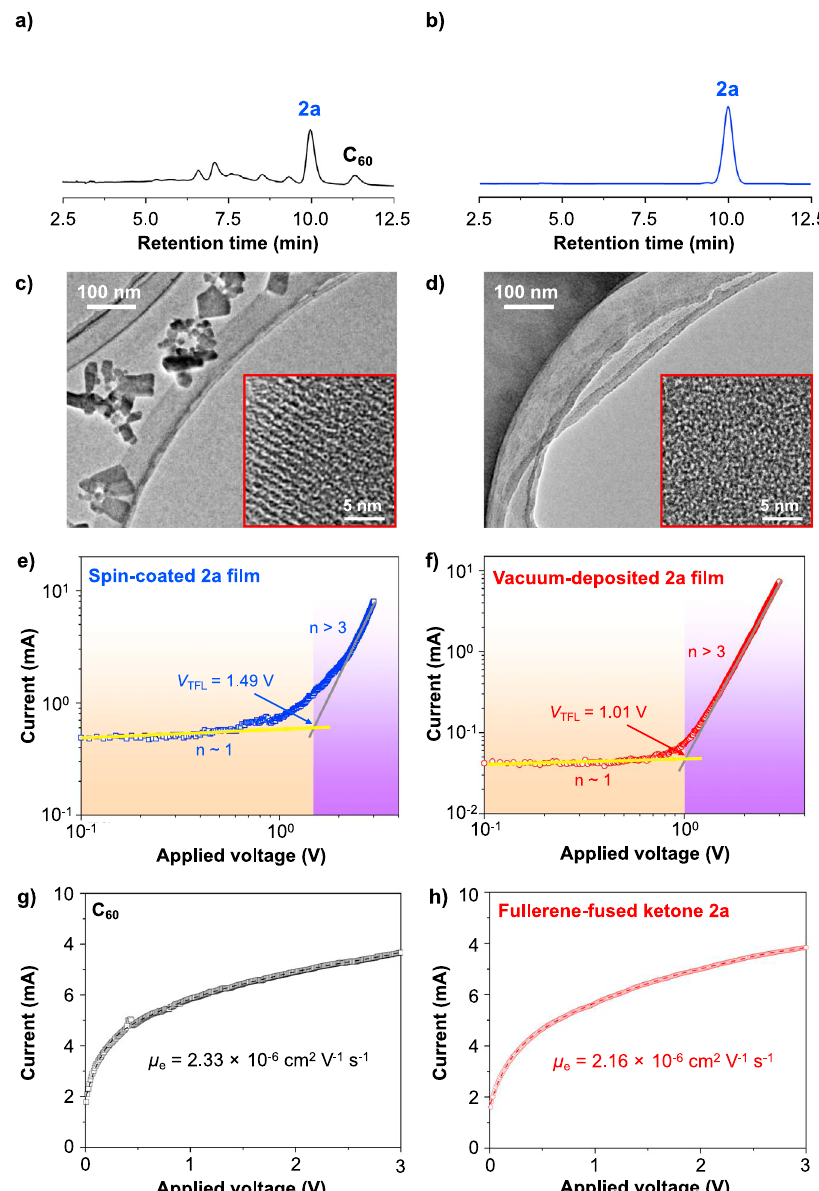
Fig. 7 Properties of evaporable fullerene-fused ketone material. HPLC analyses of a Vacuum-deposited indano[60]fullerene 1a - fi lm. b Vacuum- deposited [60]fullerene-fused ketone 2a - fi lm. TEM observations of c Spin-coated 2a - fi lm and d Vacuum-deposited 2a - fi lm with the magni fi cation as an inset. Trap density measurement of e Spin-coated 2a - fi lm and f vacuum-deposited 2a - fi lm. The SCLC based electron mobility measurement of g vacuum- deposited C 60 - fi lm and h Vacuum-deposited 2a - fi